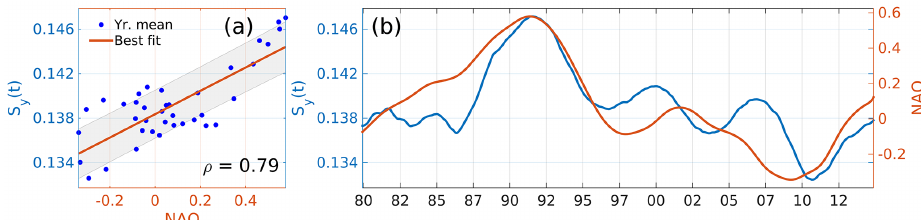
Figure 7. Time-varying standard deviation S y (t) estimated by means of the TS methodology vs. the yearly average of the NAO index, indicated by scatter plot (a) and time series (b)